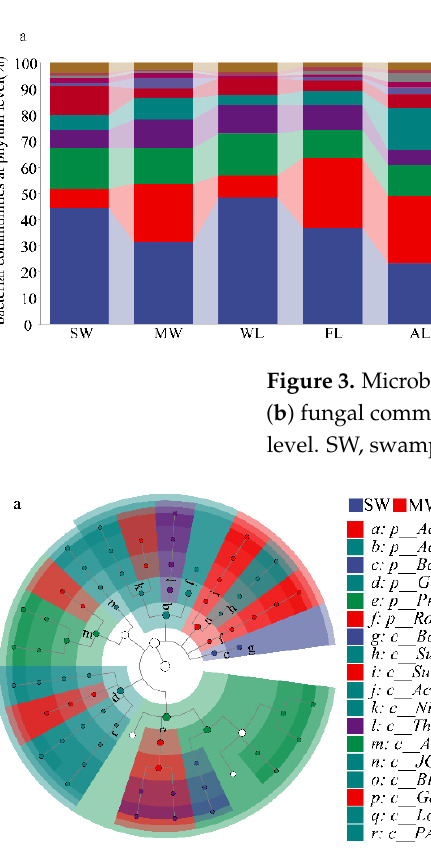
Figure 4. Cladogram of soil microbial abundance in different treatments identifies the significantly different abundant taxa. ( a ) Bacterial community abundance; ( b ) fungal community abundance. SW, swamp wetland; MW, meadow wetland; WL, woodland; FL, farmland; AL, alkaline land.